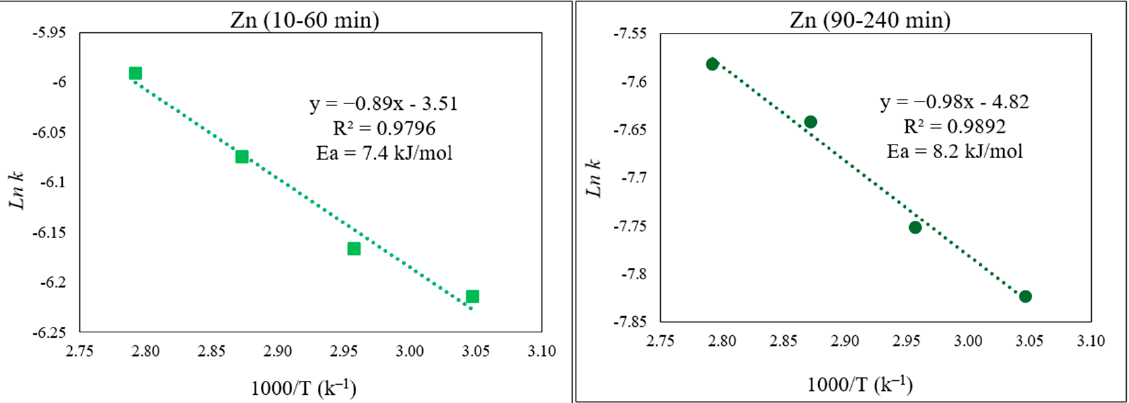
Figure 12. Arrhenius plot of ln k vs. 1000/T for Zn for the first part of the extraction (10–60 min) and the second part (90–240 min) of the extraction.